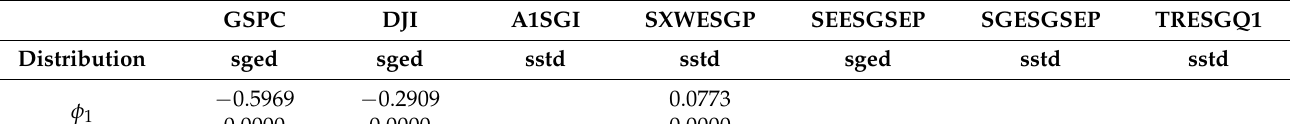
Table A3. ARMA-EGARCH models, 2 December 2009–30 July 2014.